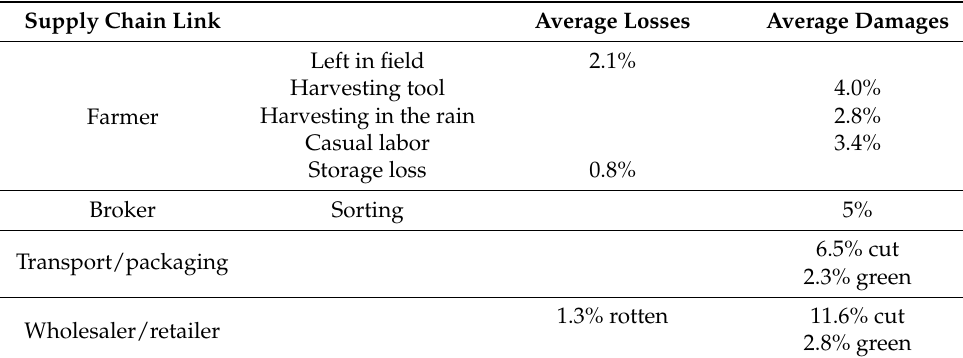
Table 5. Losses and Damages in the Potato Value Chain in Kenya [17].